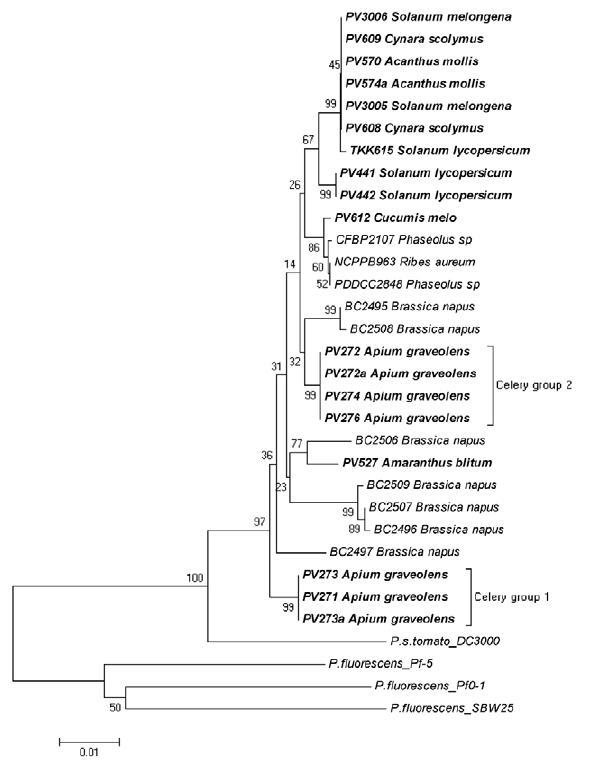
Figure 4. P. viridiflava phylogenetic trees, utilizing rpoD sequences along with sequences obtained from GenBank. The evolutionary history was inferred using the Neighbor-Joining method. Tree construction and evolutionary distances were carried out as described in the Figure 2 legend. The analysis involved 32 nucleotide sequences. All positions containing gaps and missing data were eliminated. There were a total of 513 positions in the final dataset. The methodology used for the evolutionary analysis, tree construction and other details are described in the Figure 3 legend.